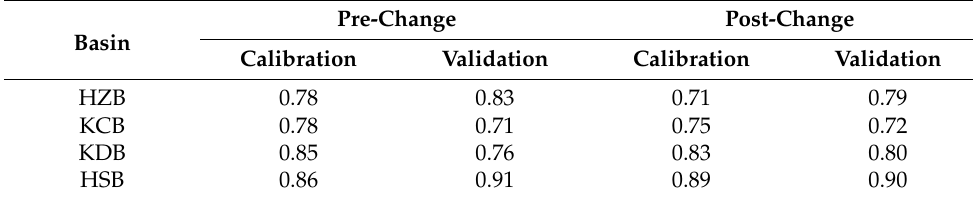
Figure 6. Simulated streamflow by abcd model in the four basins for pre-change period and post- change period. Table 1. Performance (NSE value) of abcd model for monthly streamflow